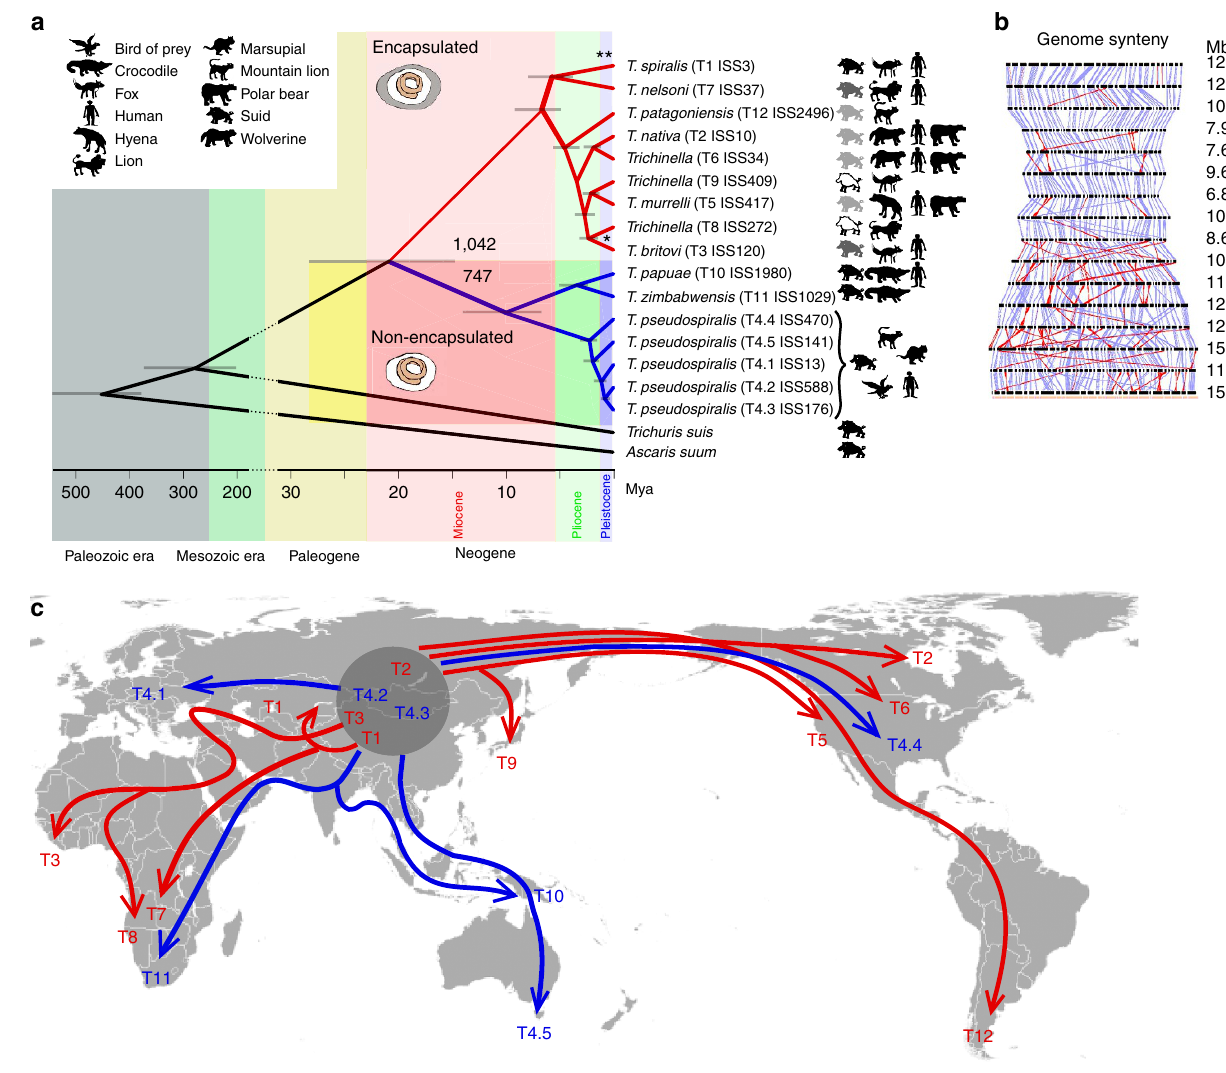
Figure 1 | The evolution and biogeography of Trichinella taxa. ( a ) The phylogeny of all 12 currently recognized taxa of Trichinella based on analyses of amino-acid sequence data from shared SCOs ( n ¼ 1,284) employing Bayesian infererence, ML and MP methods, with Trichuris suis and A. suum as outgroups; 1,042 and 747 are the numbers of orthologous gene groups, which are unique to encapsulated (red) and non-encapsulated (blue) Trichinella taxa, respectively. The topology of the trees constructed using each of these methods was the same; all nodes have absolute statistical support (1.00 or 100%), except for one node (*) in the ML analysis, where it was 99%. The grey bars on the nodes represent 95% confidence intervals for the estimate of species branching time. T. spiralis (ISS195) 19 shares the same phylogenetic position (**) as T. spiralis (ISS3). Host animals: suids ( Sus scrofa ) represent both the sylvatic and domestic porcine hosts (left); the reproductive potential of a particular Trichinella taxon in S. scrofa 12 is indicated by the colour scale: white: not assessed; light grey: low; dark grey: medium; black: high. Other animals (right) represent examples of carnivorous sylvatic hosts in different geographic regions, including fox, lion, mountain lion, marsupial, crocodile and bird of prey, and the accidental human host. ( b ) Representation of genome-wide synteny among Trichinella taxa (same order as listed on the right in a ). Genomic scaffolds (black) sharing at least 10 SCOs between Trichinella taxa are displayed. A purple line indicates a single SCO and a red line an inverted SCO. The numbers on the right indicate the genomic length in megabases (Mb). ( c ) Biogeography of Trichinella taxa proposed on the basis of known global (climate, extinctions and/or tectonic) events and diversification times (mya) for Trichinella taxa, estimated using a molecular clock approach. Encapsulated taxa: T. spiralis , T1; T. nativa , T2; T. britovi , T3; T. murrelli , T5; T. nelsoni , T7; T. patagoniensis , T12; and Trichinella genotypes T6, T8 and T9. Non-encapsulated taxa (infecting mammals, reptiles and/or birds): T. pseudospiralis , T4; T. papuae , T10; T. zimbabwensis , T11 (ref. 12). Geographic distributions of Trichinella taxa were reported by Pozio and Zarlenga 11 . The embedded public domain world map image (https://commons.wikimedia.org/wiki/File:BlankMap-World6.svg) has been modified using the programs World map tool v.1.16 (http://law.nagoya-u.ac.jp/en/appendix/software/worldmap) and GIMP v.2.8